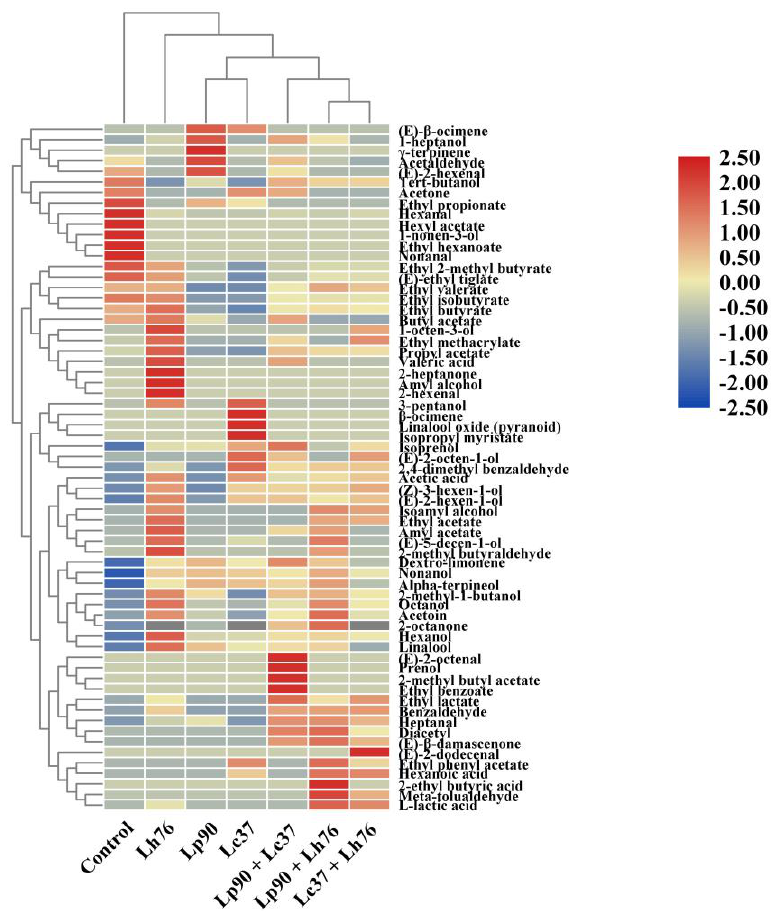
Figure 5. Hierarchical cluster and heat map of volatiles profile in unfermented and fermented pear juices by monoculture and binary mixture of lactic acid bacteria. The color scale represents the scaled abundance of each variable, denoted as d 2 (squared Euclidean distance), with red indicating high abundance and blue indicating low abundance. Abbreviations: Lp90, Lactiplantibacillus plantarum 90; Lc37, Lacticaseibacillus casei 37; Lh76, Lactobacillus helveticus 76; Lp90 + Lc37, mixture of Lactiplantibacillus plantarum 90 and Lacticaseibacillus casei 37; Lp90 + Lh76, mixture of Lactiplantibacillus plantarum 90 and Lactobacillus helveticus 76; Lc37 + Lh76, mixture of Lacticaseibacillus casei 37 and Lactobacillus helveticus